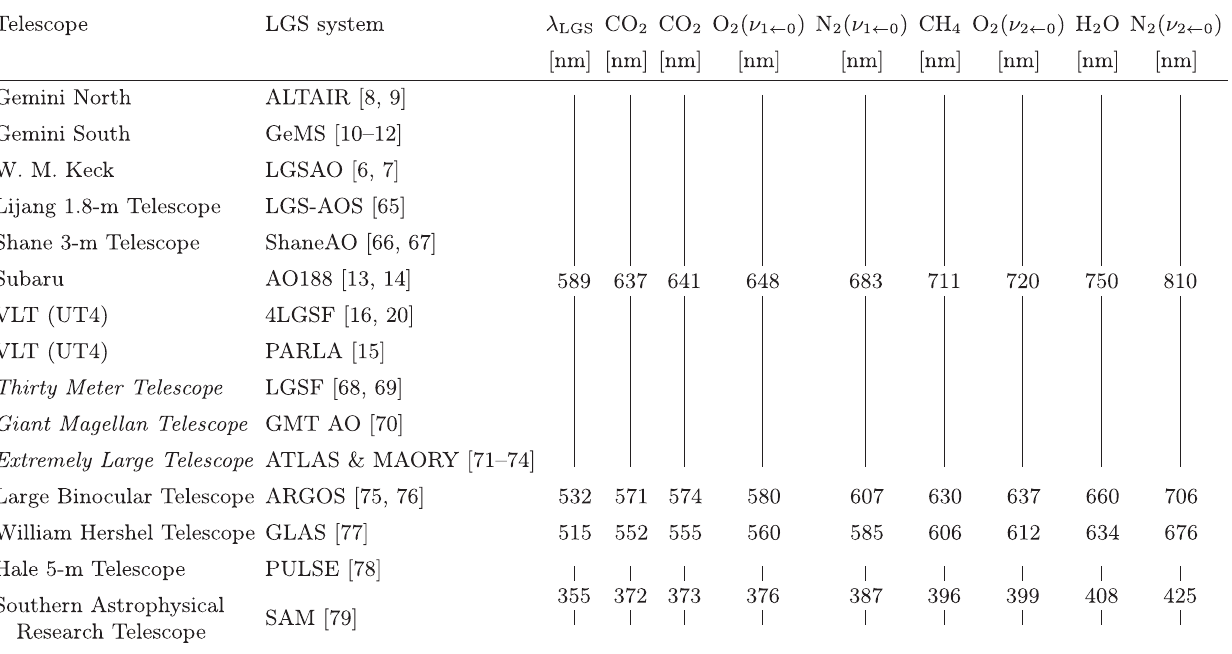
TABLE II. Wavelength of the main atmospheric, laser-induced Raman scattering lines as a function of the LGS wavelength λ different astronomical